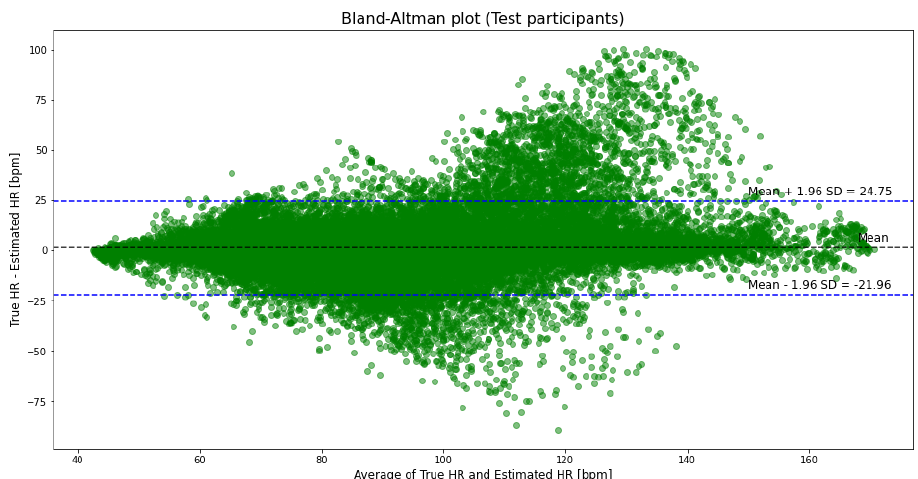
Figure 2. Bland–Altman plot for all participants from PPG-DaLiA dataset. Analysis for all 64,697 HR estimated values, with 3544 (5.48%) points outside the limits of agreement.